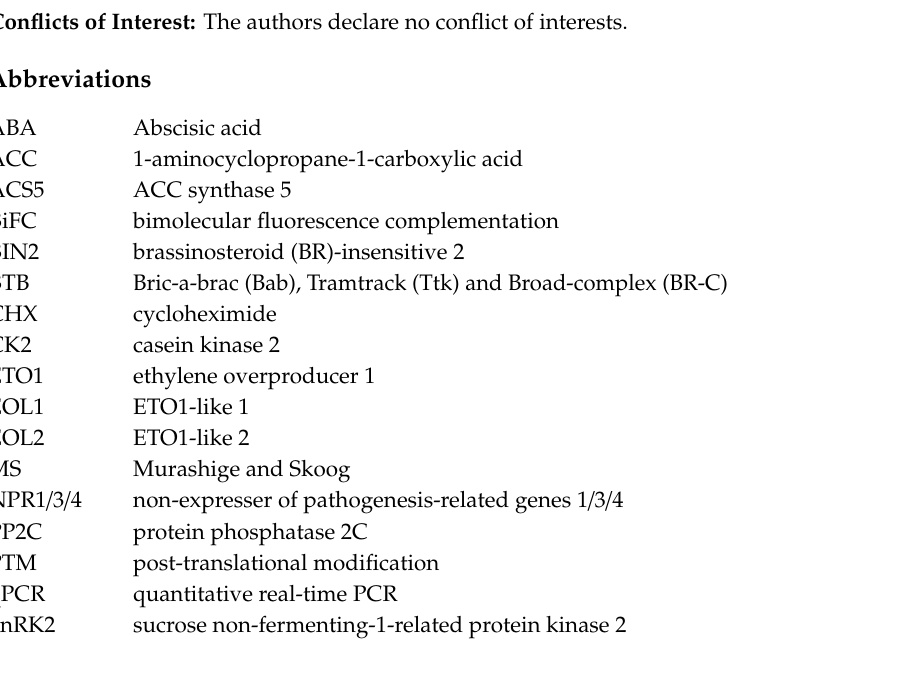
Figure S1: Sequence alignment of representative BTB proteins in animals and plants and transmembrane prediction of Arabidopsis BTB-A2.1, BTB-A2.2, and BTB-A2.3., Figure S2: Identification of btb-a2 single mutants, double mutants and triple mutant. Figure S3: Arabidopsis BTB-A2s may function in polycomplex. Figure S4: The growth situation of Arabidopsis btb-a2.1 / 2 / 3 in normal condition at each growth stage. Figure S5: Arabidopsis btb-a2.1 / 2 / 3 displayed no di ff erent performance compared with WT in SA and ethylene conditions. Figure S6: Analysis of cis -elements in the promoter of AtBTB-A2s . Figure S7: Arabidopsis btb-a2 single and double mutant display no sensitivity to ABA in germination. Figure S8: Expression levels of ABA synthesis related genes in WT and triple mutant btb-a2.1 / 2 / 3 . Figure S9: BTB-A2.1 may do not interact with PP2Cs. Figure S10: The interactions between BTB-A2.1, BTB-A2.2, and BTB-A2.3 with SnRK2.6 by BiFC assays in N. benthamiana leaves. Figure S11: Expression levels of BTB-A2.1 , BTB-A2.2 and BTB-A2.3 in transformed Arabidopsis plants by qPCR. Figure S12: Overexpression of BTB-A2.2 , BTB-A2.3 inhibits the ABA hypersensitive phenotypes of lines overexpressing SnRK2.3 . Table S1: Primers used in this